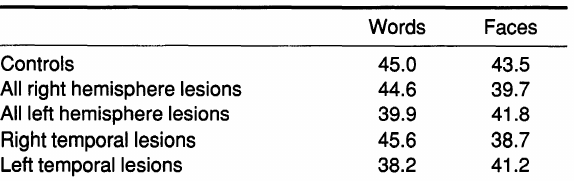
TABLE I. Summary of norms on the Warrington Recognition Mem ory Tests (1984)